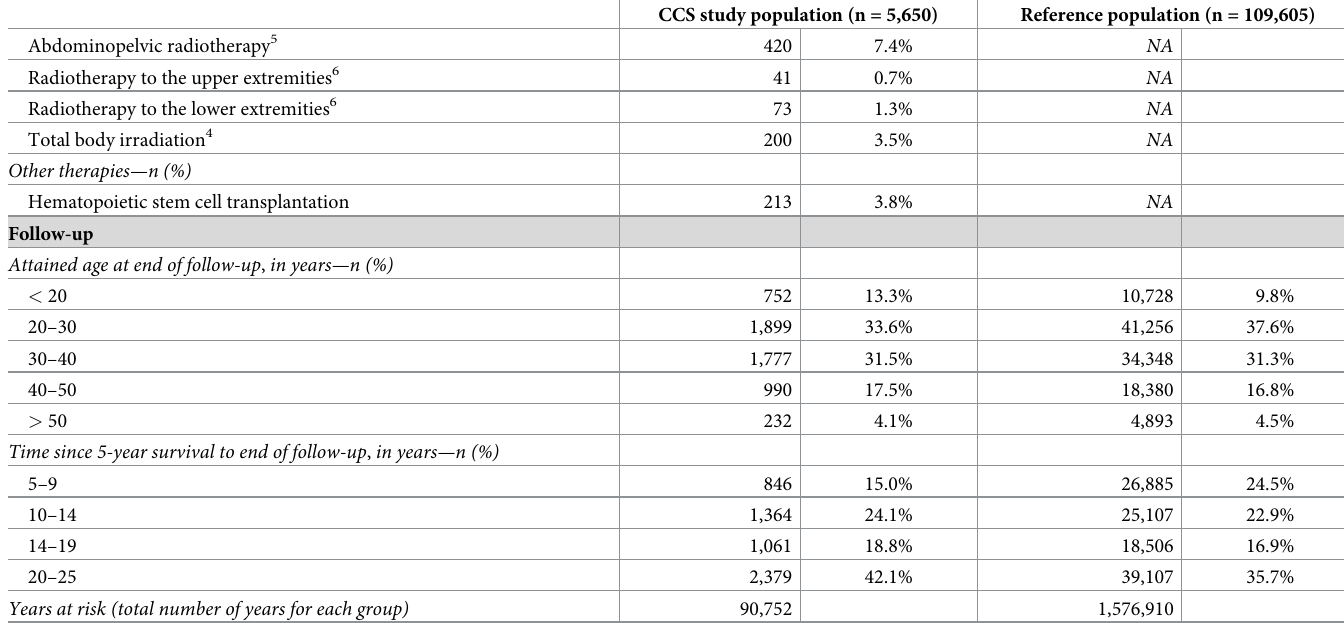
Abbreviations: CCS: Childhood Cancer Survivors 1 Variables used for matching of CCS to the reference population 2 Age at diagnosis and treatment period were calculated for the reference population using the assigned date of diagnosis from their corresponding CCS 3 Variable options are mutually exclusive